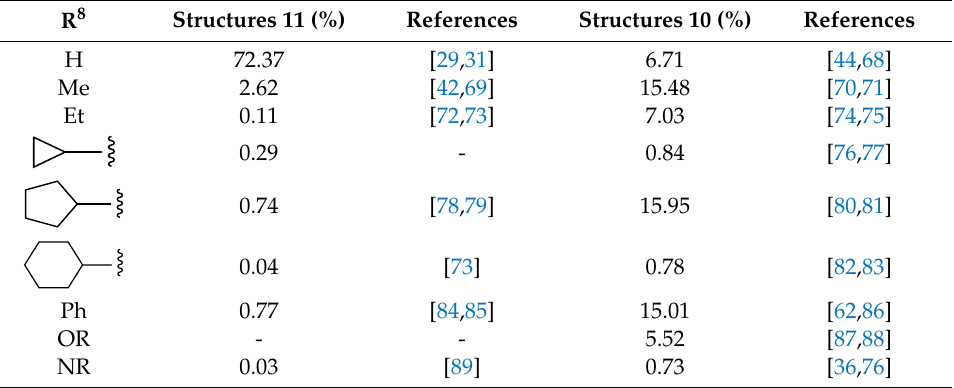
Table 3. Substitution pattern at N8 of 5,6-dihydropyrido[2,3- d ]pyrimidin-7(8 H )-ones ( 11 ) with a C5-C6 single bond and the pyrido[2,3- d ]pyrimidin-7(8 H )-ones ( 10 ) with a C5-C6 double bond. R